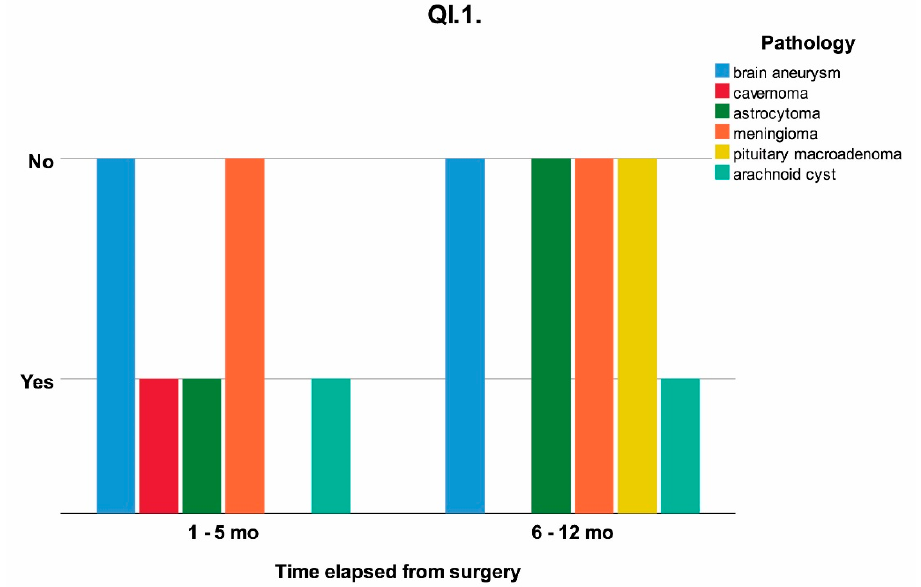
Figure 2. The response at QI.1 (“Do you feel pain in your temple or in the anterior region of the ear when you yawn?”) influenced by the time elapsed from surgery clustered on the initial pathology; mo = months.